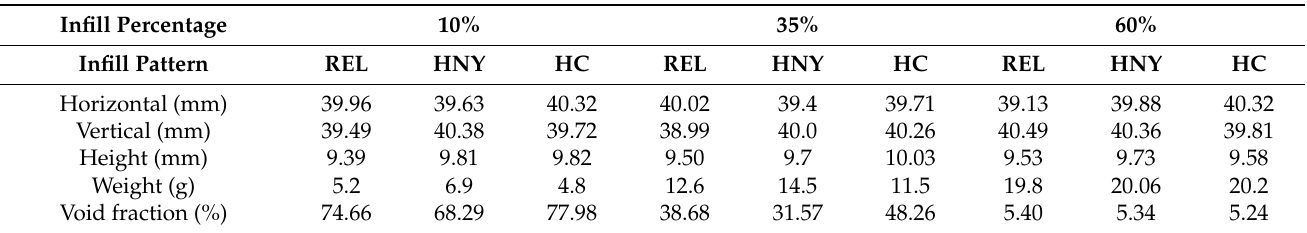
Table 4. Dimensional accuracy of 3D-printed candy specimens with infill densities of 10%, 35%, and 60%, with various infill